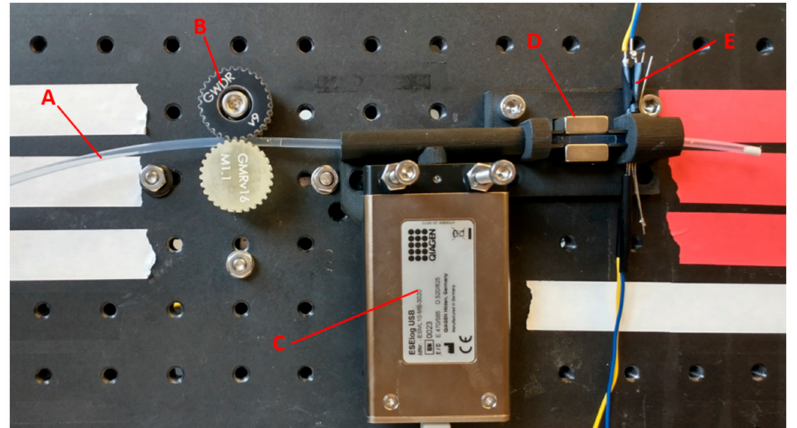
Figure 2. Photograph of the autoPiLOT reaction processor. Microfluidic polymer tubing (A) contains the reaction solutions. Two gears (B) controlled by a stepper motor move the tubing. A fluorometer (C) measures the fluorescence on the beads inside a light-tight chamber. Two neodynium magnets (D) hold the magnetic beads in their field. An IR sensor/receiver pair (E) detects the liquid/air interfaces in the tubing.